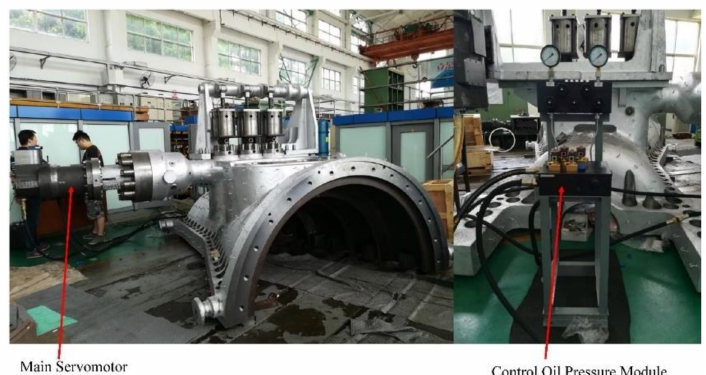
Figure 7. Physical diagram of system